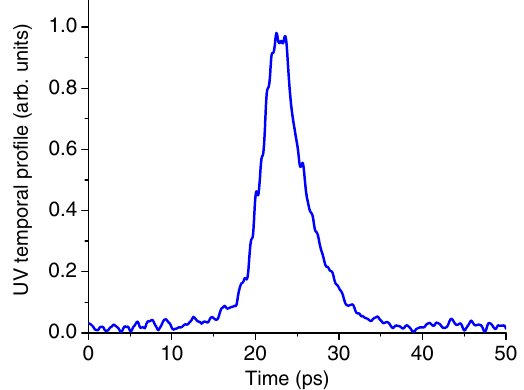
FIG. 3. Longitudinal pulse profile of the Nd ∶ YLF laser, measured with cross-correlation in the